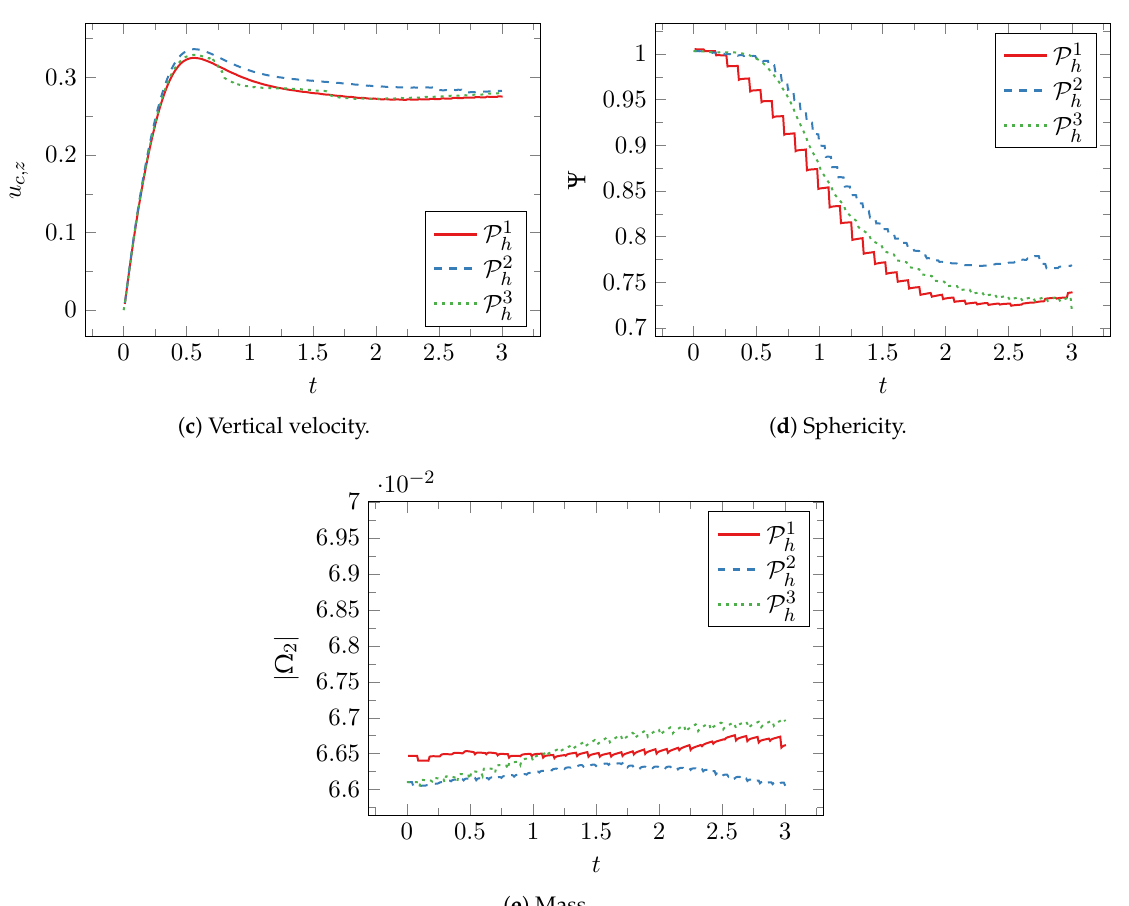
Figure 13. Comparison between P 1